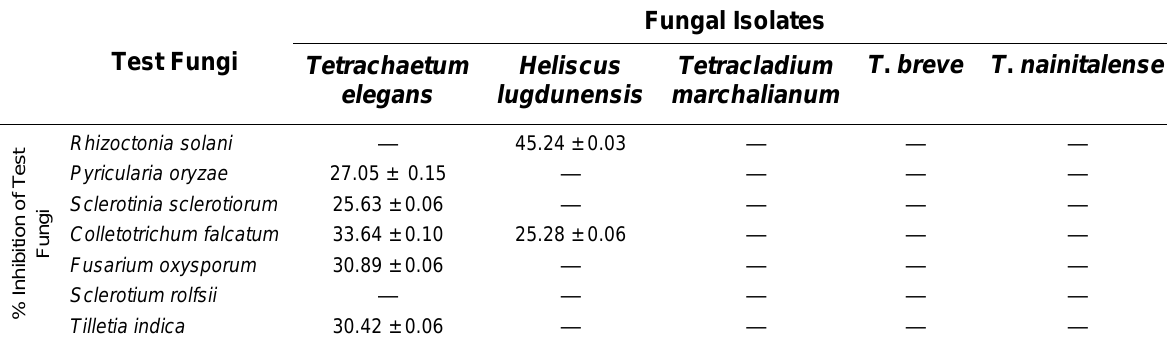
Percent Inhibition of Seven Pathogenic Fungi Against Five Aquatic Hyphomycetes (± SEM